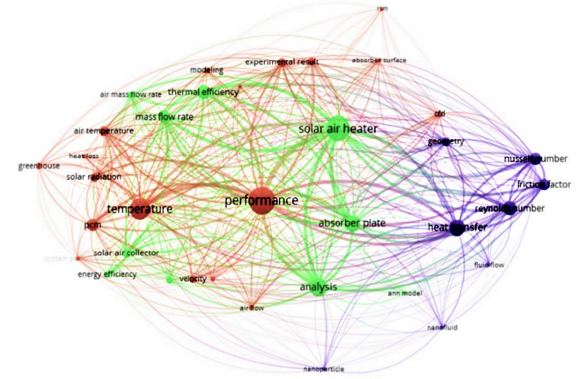
Figure 8. Solar air heaters keyword bibliometric overlap network.